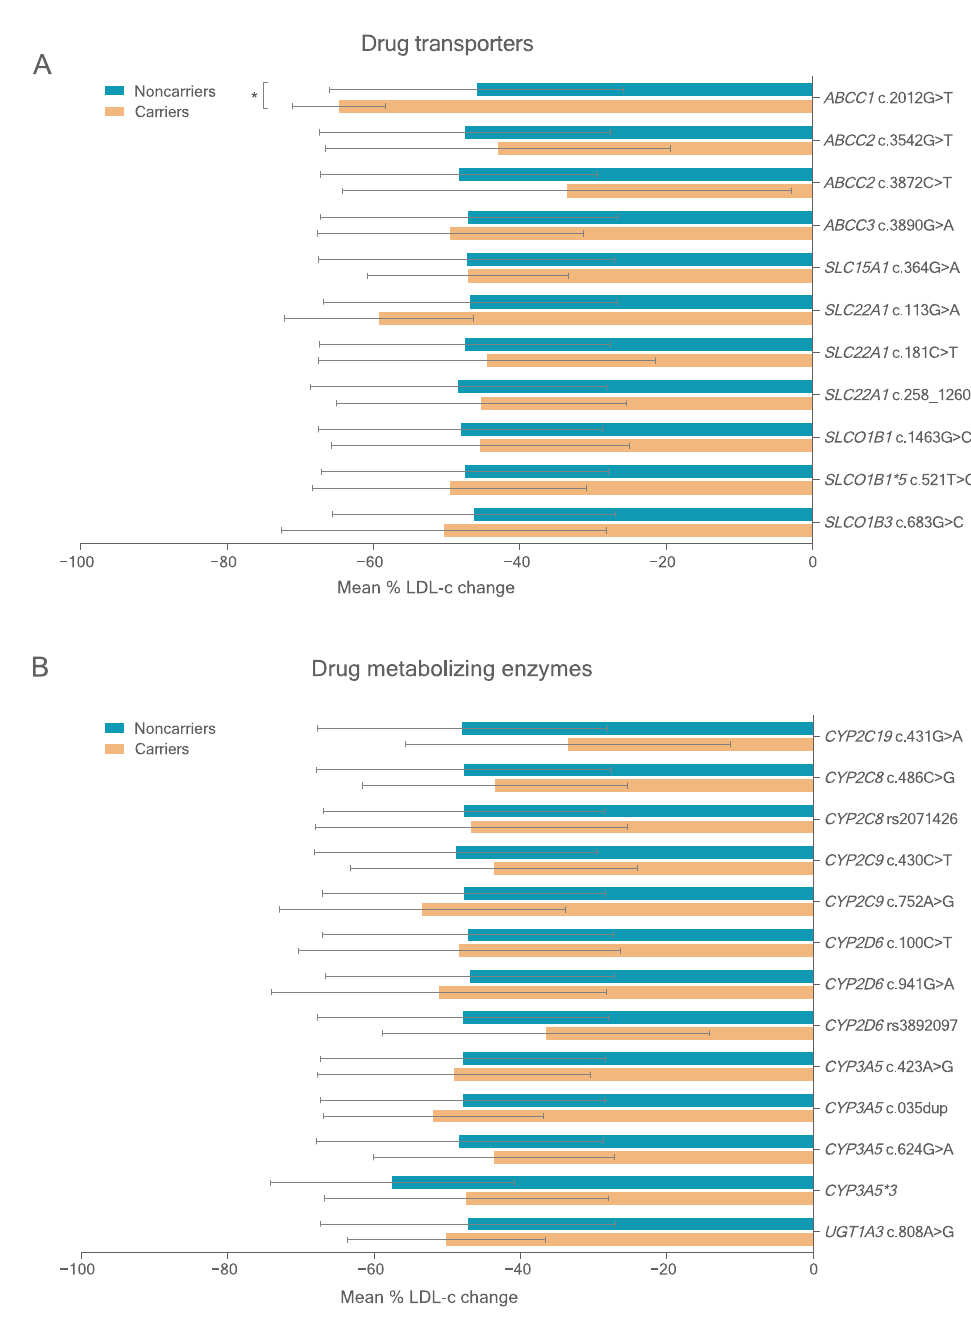
Figure 2. Mean LDL cholesterol response percentage change) after lipid-lowering treatment in FH patients carrying deleterious variants in PK genes (MAF > 5.0%). ( A ) Variants in ABC and SLC transporters. ( B ) Variants in CYP and UGT metabolizing enzymes. * p < 0.05 (compared by t -test).